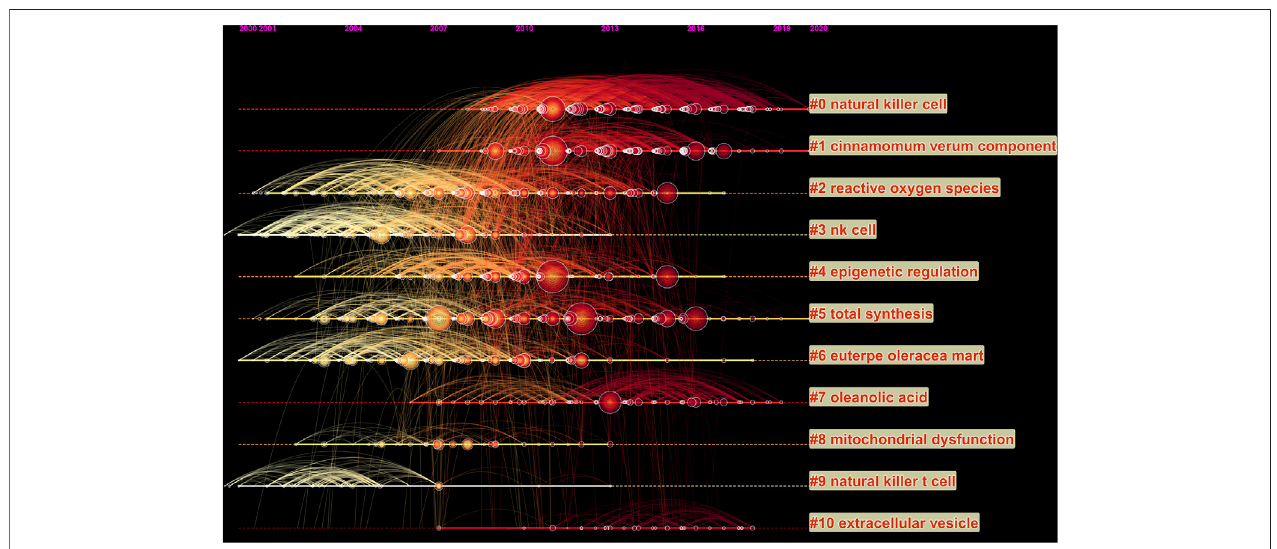
FIGURE 4 | Timeline view of co-cited references related to natural products in cancer research. The cluster with warmer color and larger nodes contained more publications, indicating that this clustering issue was the hotspot in this fi eld.